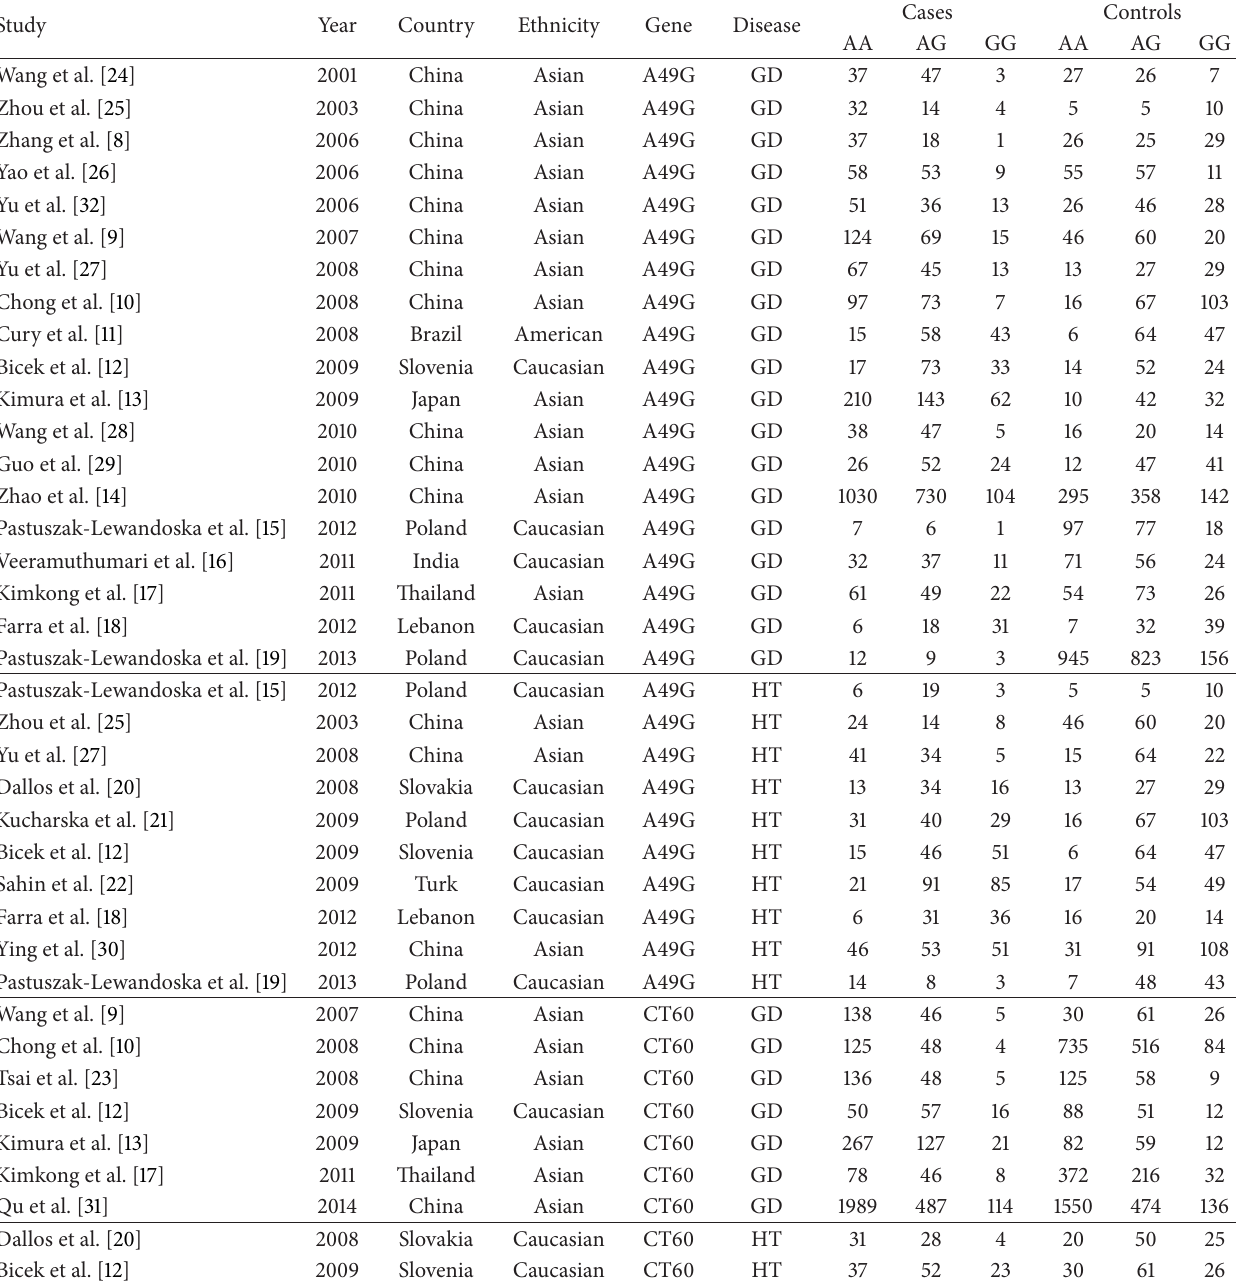
Table 1: Characteristics of new studies included in the